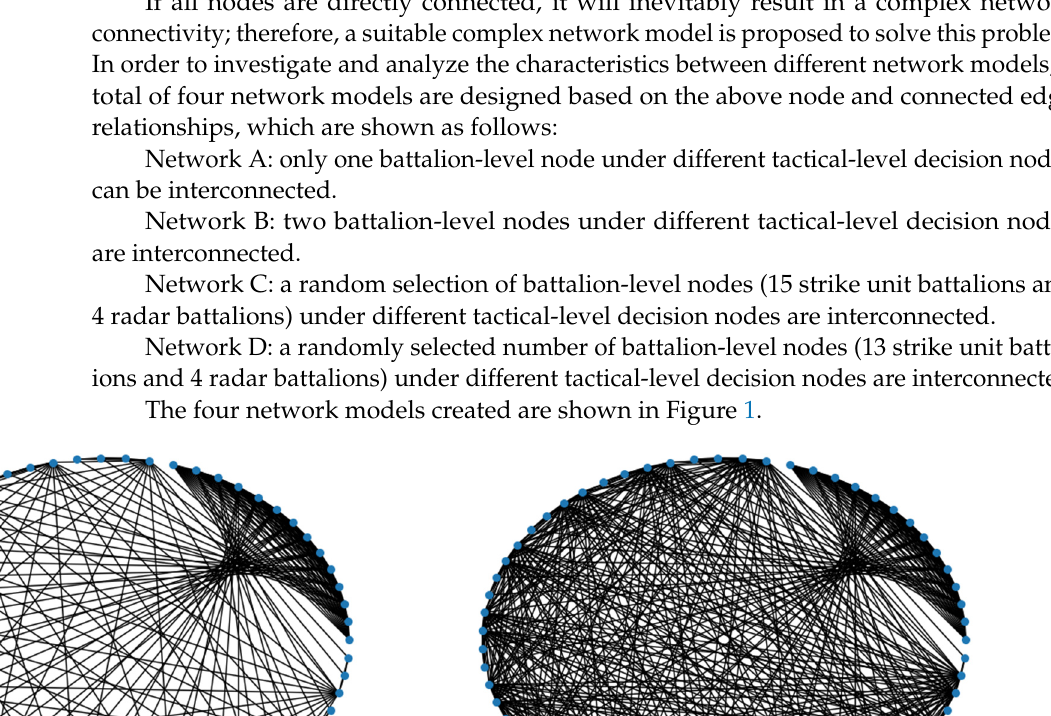
( d ) Figure 1. The network model of C2 system. ( a ) Network A; ( b ) Network B; ( c ) Network C; ( d ) Net- work D. As can be seen from Figure 1, Network A has a simpler structure with fewer edges, while the model is more complex due to the higher number of edges in Network B, Net- work C, and Network D. The four networks have 287, 521, 374 and 326 connected edges, respectively. 3. Network Characteristics and Index Selection In order to analyze the commonality and dissimilarity of the four network models, we can consider comparing the networks from multiple perspectives and dimensions, which are mainly divided into topology and destruction resistance research. 3.1. Topology Indicators (1) The number of edges of the network The greater the number of edges, the greater the communication between the nodes of the network, and the faster the transmission of instructions; however, at the same time, it makes the network more redundant, which makes the cost of combat much higher and places higher demands on the reliability of the network. (2) Average node degree and degree distribution The degree of a node is also known as the degree of association. In a complex net- work, the degree represents the connectivity of the node with other nodes. The higher the